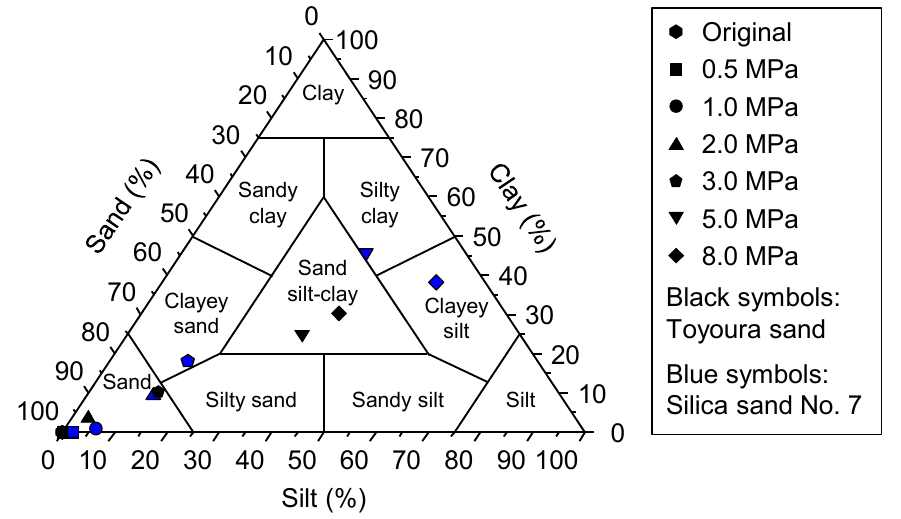
Figure 9. Classification of shear zone sample after ring-shearing using the triangle diagram developed by Shepard